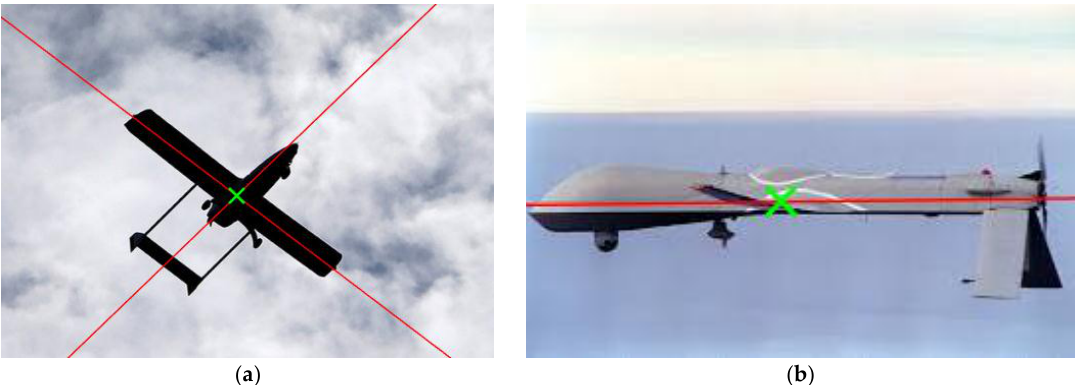
Figure 5. The results of parallel line clustering. ( a ) The directions of the fuselage and the wings are extracted correctly; ( b ) The direction of the wings cannot be extracted for this extreme pose.